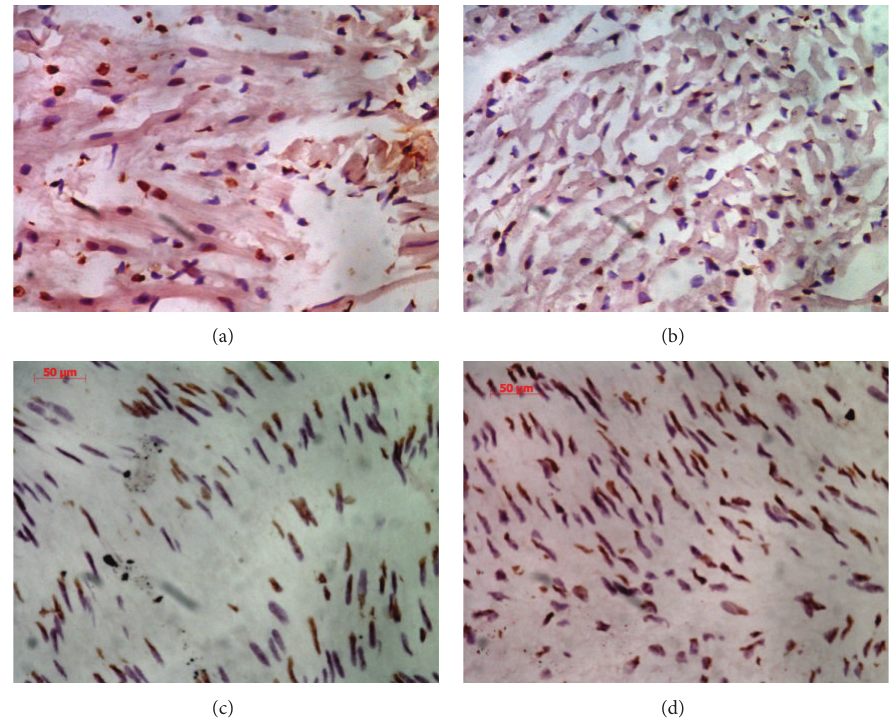
Figure 3: Aortic endothelial cell apoptosis TUNEL analysis results. (a), (b) Aortic endothelial cell apoptosis in the control group after 12h (a) and 24 h (b). (c), (d) Aortic endothelial cell apoptosis in the experimental group after 12h (c) and 24 h